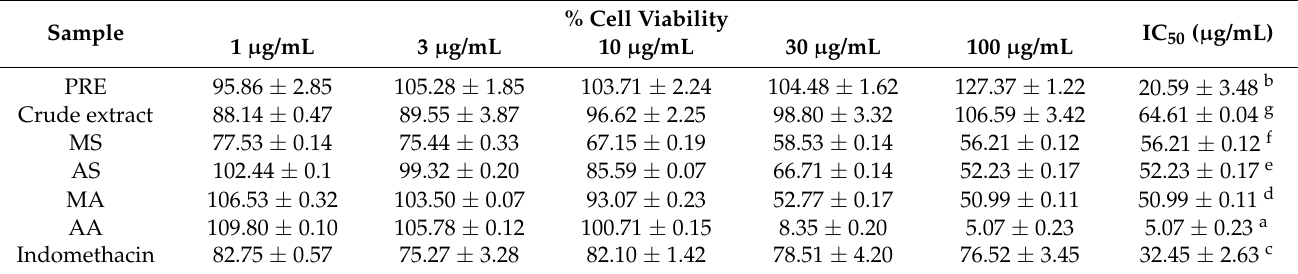
Table 3. Nitric oxide inhibitory activities of PRE, crude extract from C. asiatica , pure isolated com- pounds (MS, AS, MA, and AA), and